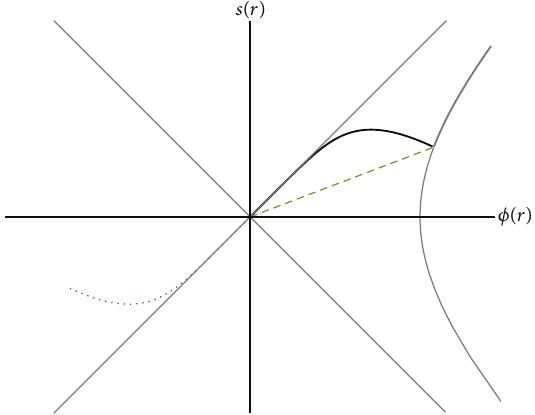
Figure 2: The figure shows a nongeneric nature of Schwarzschild singularity and also a singular nature of 𝐸 -gauge (GR description) by plotting solutions in (𝜙, 𝑠) -plane. The black thick line represents a BH solution with generic space-like ( 𝐸 -gauge) singularity which is in regular gauges characterised by (𝜙,𝑠) → (0, 0) and |𝑠/𝜙| → 1 (independently of values of scalar fields in asymptotic infinity). The dashed line represents Schwarzschild BH which is in all gauges characterised by |𝑠/𝜙| = const < 1 . The point in which two solutions coincide corresponds to asymptotic infinity 𝑟 → ∞ . Solutions in 𝐸 - gauge are obtained by projecting on a hyperbola (thin gray line). We see that, for generic solution, this projection (thick gray line) is ill- defined when (𝜙,𝑠) → (0,0) in regular gauge, and this manifests itself as space-time singularity in 𝐸 -gauge. The dotted thick line represents a white hole extension (in region with negative 𝜙 and 𝑠 ). Thin grey diagonal lines are straight lines |𝜙| = |𝑠|